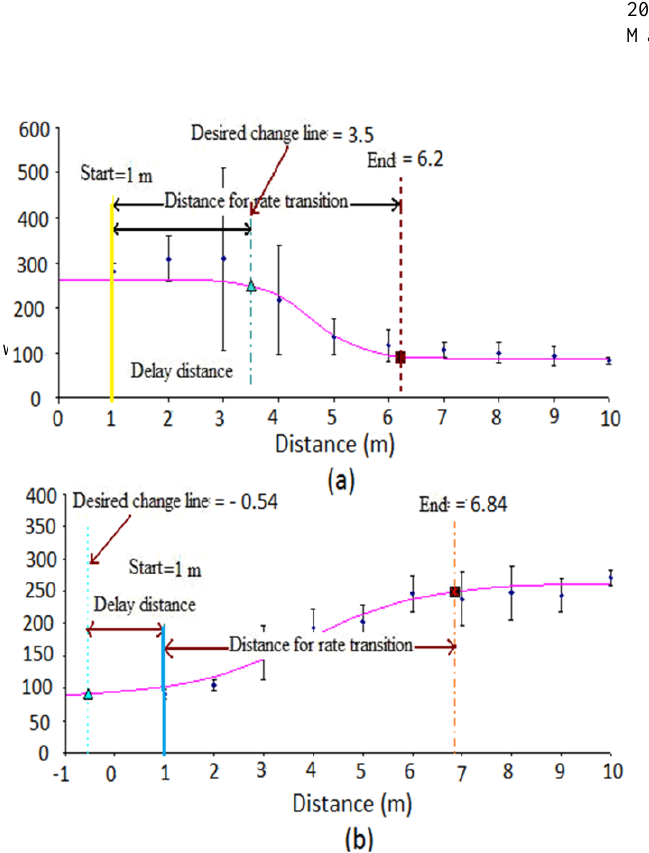
Figure 11 - Response time charts for the variable rate control system, a) change from seed rate of 262.5 to 87.5 kg / ha; and b) change from seeding rate of 87.5 to 262.5 kg /